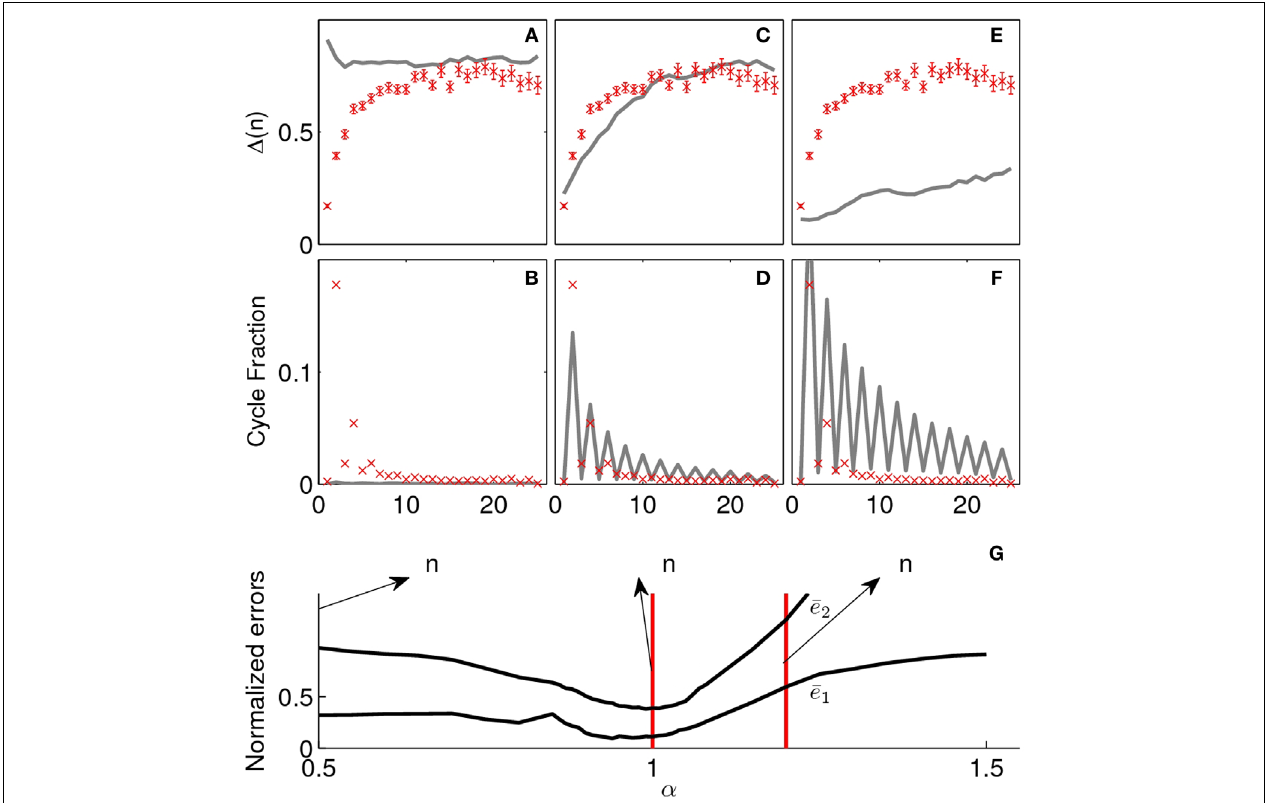
FIGURE 4 | In the upper part we present simulations of the power-law model for different values of the parameter ( α ). (A) and (B) are simulations for a small value of α (0.1). Note that jumps are made completely at random, hence, the displacement is essentially fl at and there are virtually no cycles. In (E) and (F) , the converse case is presented ( α = 1.2) and we observe that